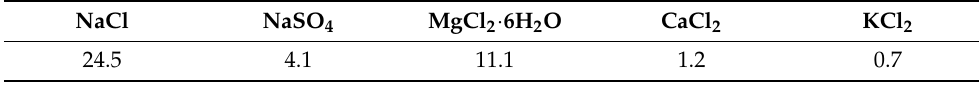
Table 2. Chemical composition of simulated seawater (kg/m 3